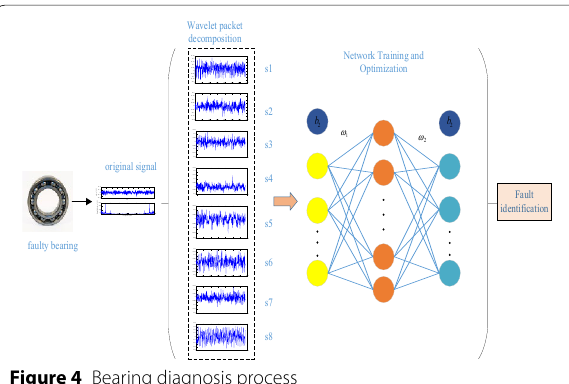
Figure 3 Neural network diagnosis flow chart